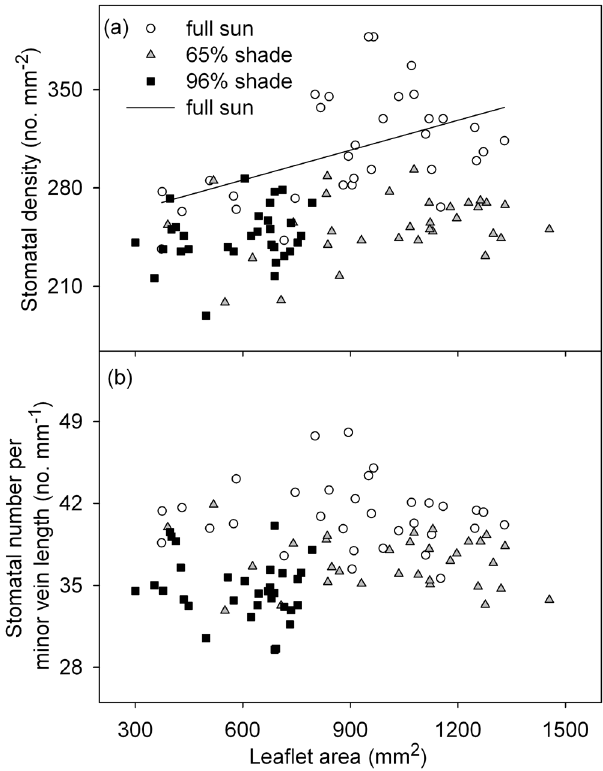
Figure 3. Relationships between leaflet area and stomatal density ( a ) and stomata number per minor vein length ( b ) for peanut plants grown in three light conditions. Each symbol represents one leaflet. The relationship between leaflet area and stomatal density was significant in full sun condition (SD = 243.1 + 0.07 × LA, r 2 = 0.24, P <